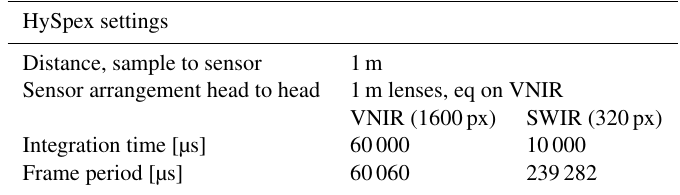
Table 4. HySpex settings for laboratory measurements of Apliki mine powdered samples (Koerting et al., 2019b).